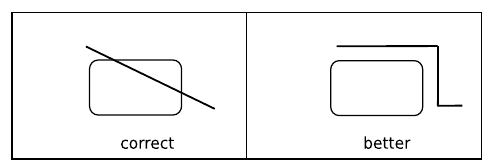
Figure 4.7: Edges should not cross